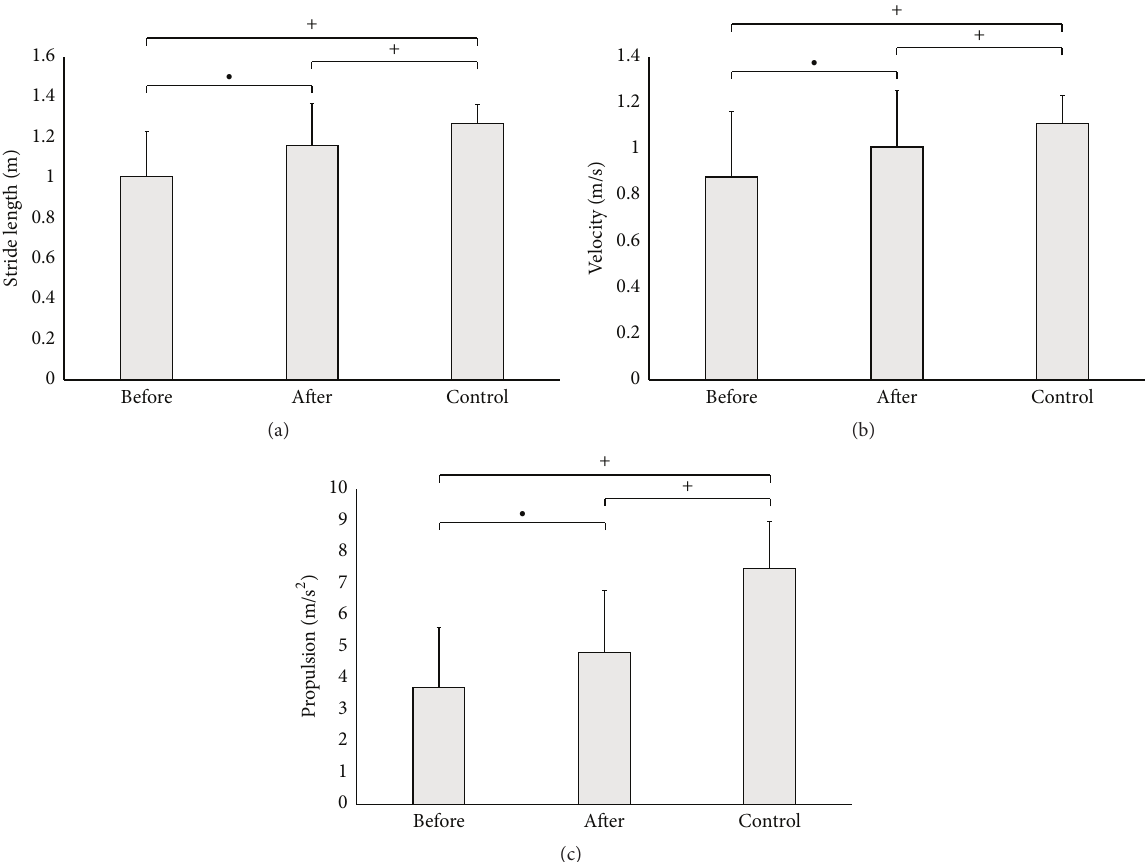
Figure 2: Significance and standard deviation of gait spatiotemporal parameters before and after AMPS: (a) stride length; (b) velocity; and (c) propulsion. ∙ = 𝑃 < 0.05 between pre- and post-AMPS; + = 𝑃 < 0.05 between PD and control group.